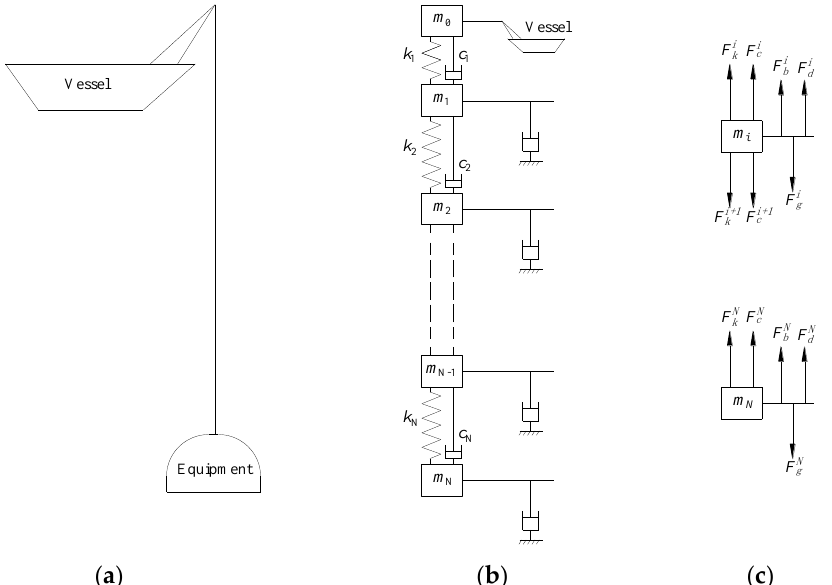
Figure 2. Mechanical model of the subsea equipment installation. ( a ) Schematic diagram of the operation; ( b ) lumped-mass model; ( c ) force balance analysis.